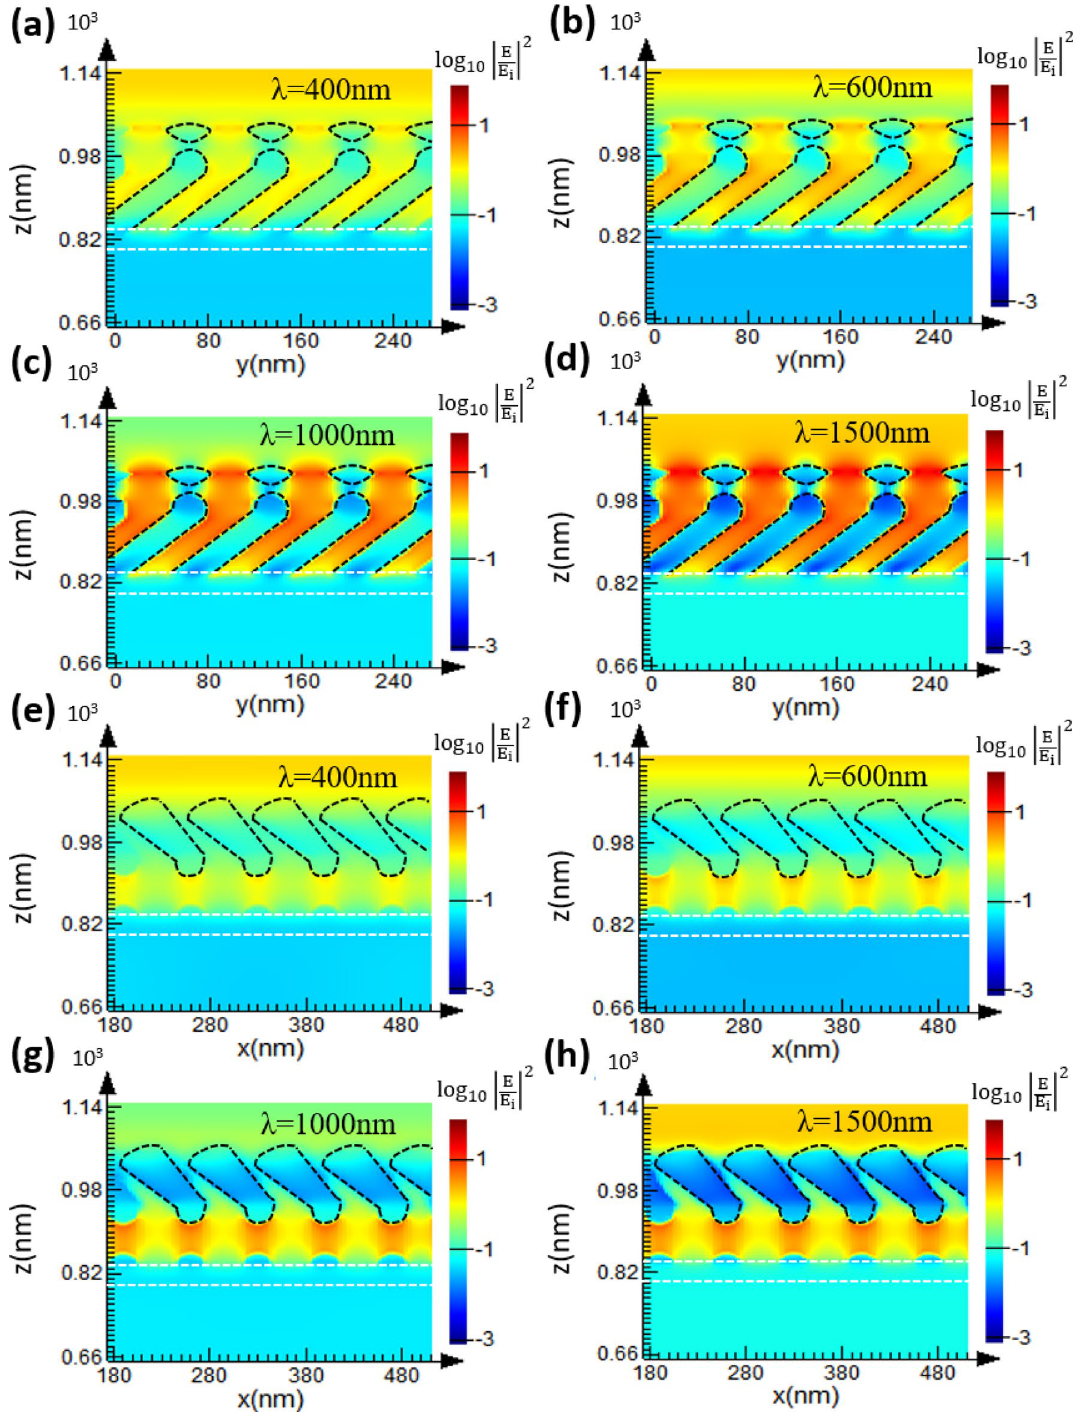
Figure 8. ( a – d ) Electric field intensity distributions for the y–z plane across the center of bottom rods; ( e – h ) Electric field intensity distributions for the x–z plane across the center of upper